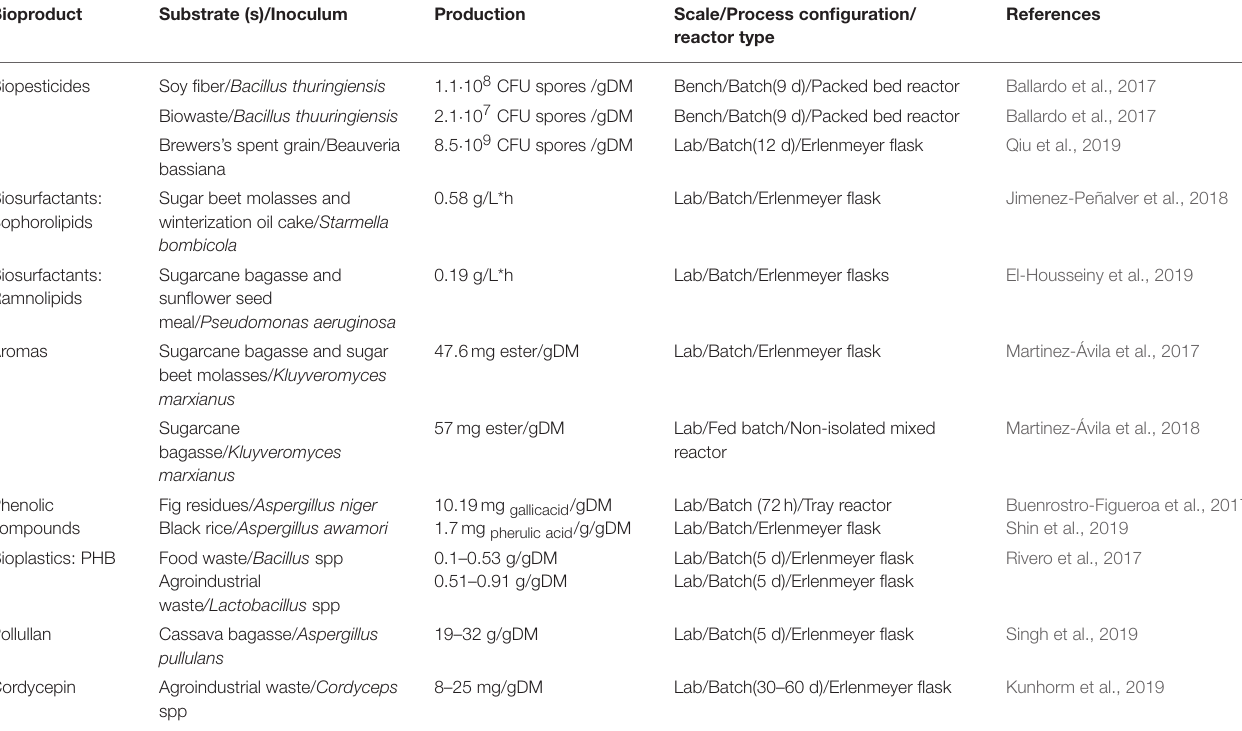
TABLE 2 | Summary of innovative bioproducts obtained by solid-state fermentation, production yields and process conditions.